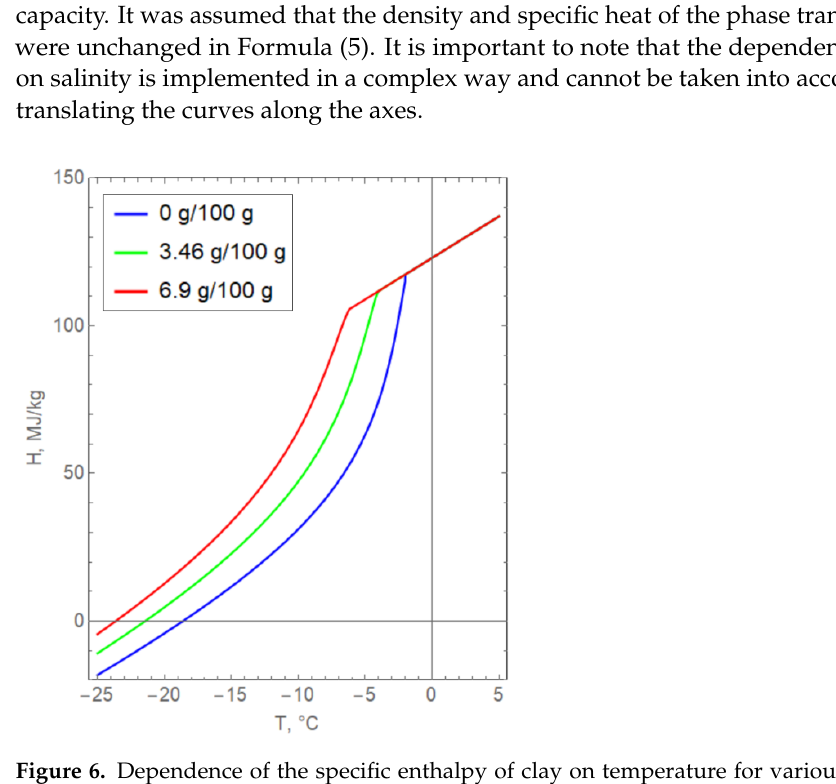
Figure 6. Dependence of the specific enthalpy of clay on temperature for various values of pore water salinity.